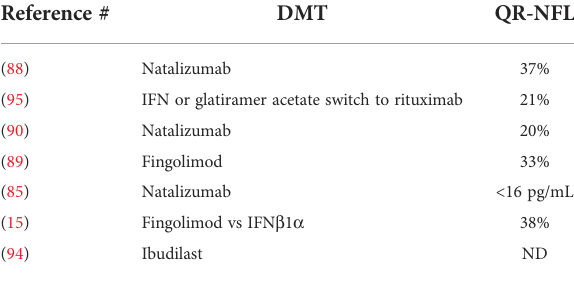
TABLE 2 Decrease in NFL level in response to disease-modifying